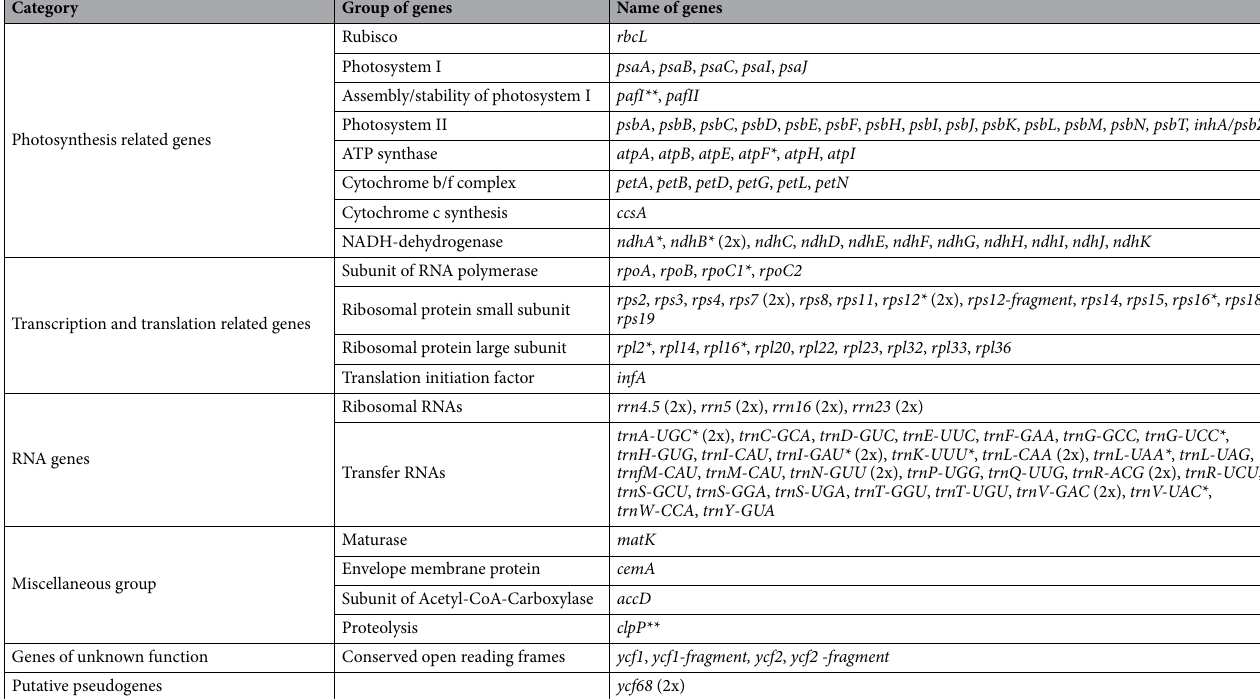
Table 2. Genes encoded by seven Ocotea plastomes. (2x)—Gene represented by two copies. *Gene containing one intron. **Gene containing two